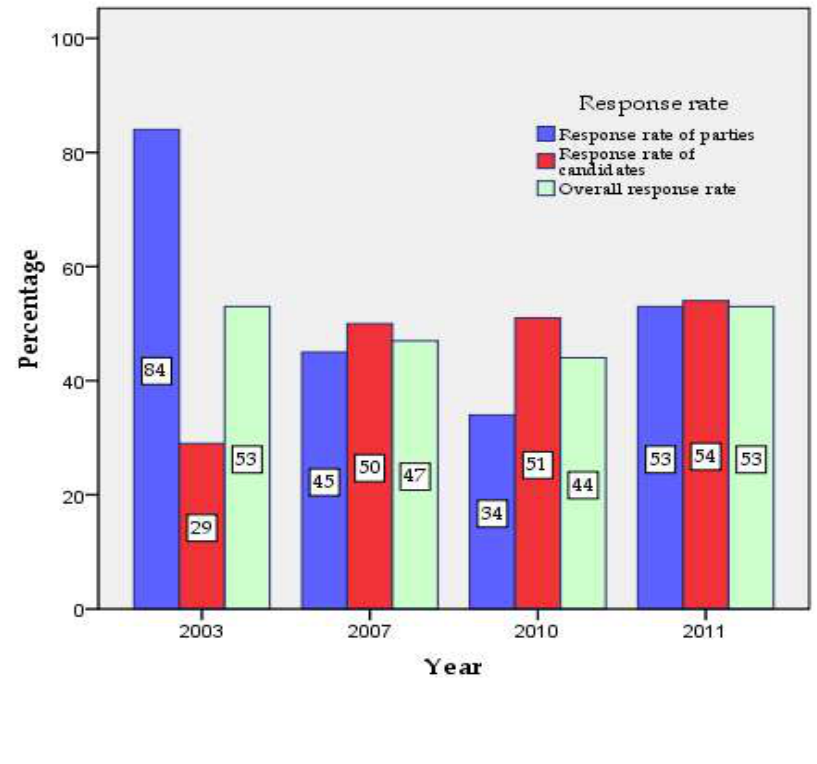
Figure 1: Email Enquiry Response Rates,